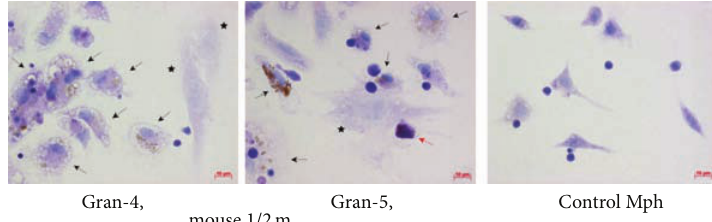
Figure 8: Immunochemical localization of the activation marker CD25 on the cells in the fragments of mouse splenic granulomas and control mouse peritoneal macrophages (Mph). The scale bars are 10 𝜇 m each. The brown color indicates the presence of the receptor in these cells. Macrophages and dendritic cells with CD25 in them are indicated by the black and red arrows, respectively. The black stars indicate the fibroblasts that do not contain the antigen. Abbreviations as in Figure